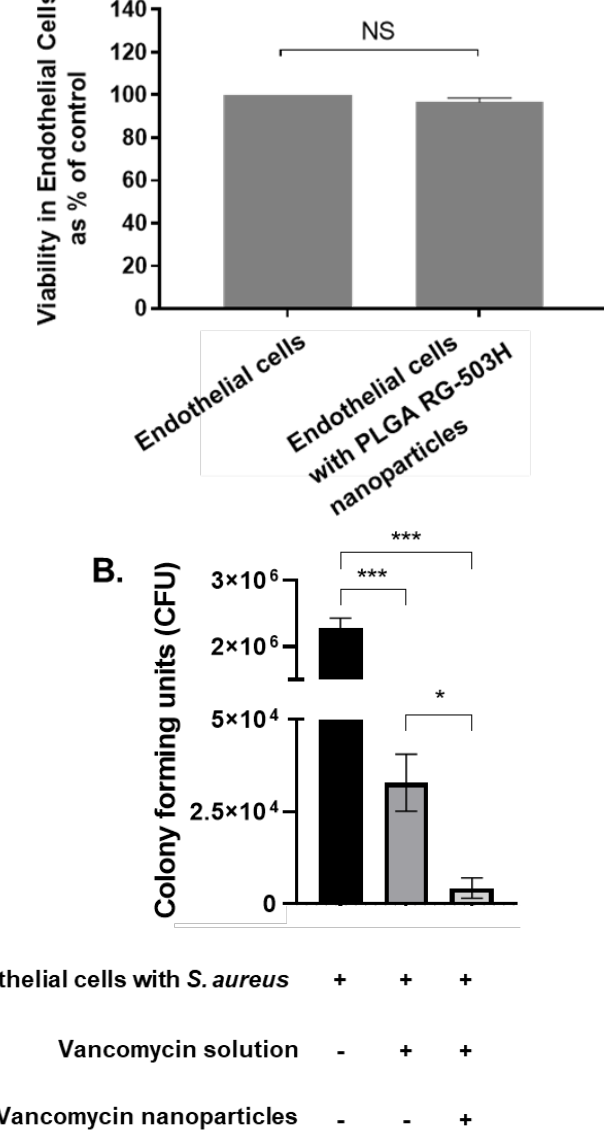
Figure 5. Effectivity of PLGA RG-503H nanoparticles on infected human endothelial cells in vitro. ( A ) MTT assay was performed to assess toxicity of PLGA RG-503H nanoparticles on human aortic endothelial cells. No significant difference was observed between untreated and treated cells after exposure for 24 h. ( B ) S. aureus 8325-4-infected endothelial cells were treated with either concen- trated vancomycin solution (0.5 mg/mL), or both vancomycin solution and 10% vancomycin- loaded nanoparticles (0.5 µg/mL). Cells were lysed, and the total amount of external and internal